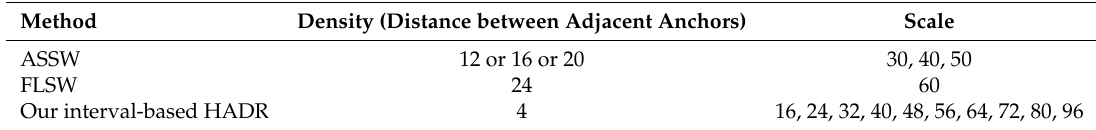
Table 4. The density and scale of anchors (unit is a sampling point).